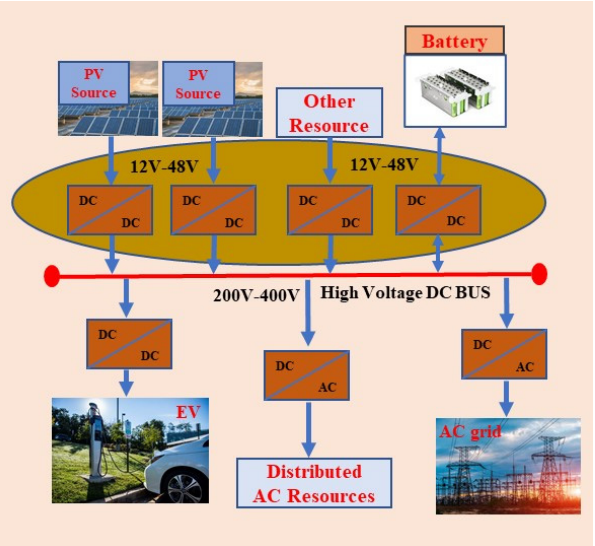
Figure 1. Application of integrated DC-DC converter for the next-generation energy system.